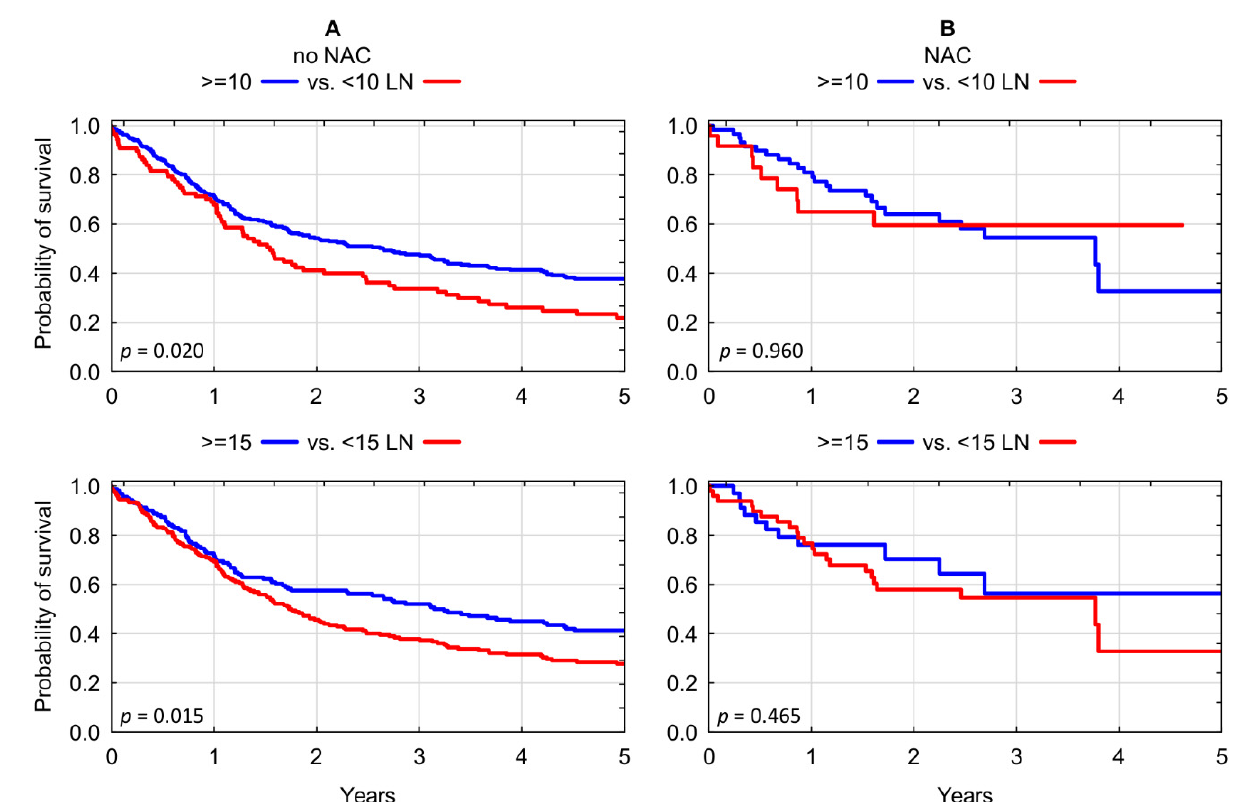
Table 3. Three-year overall survival of patients who underwent radical cystectomy according to the number of dissected lymph nodes.